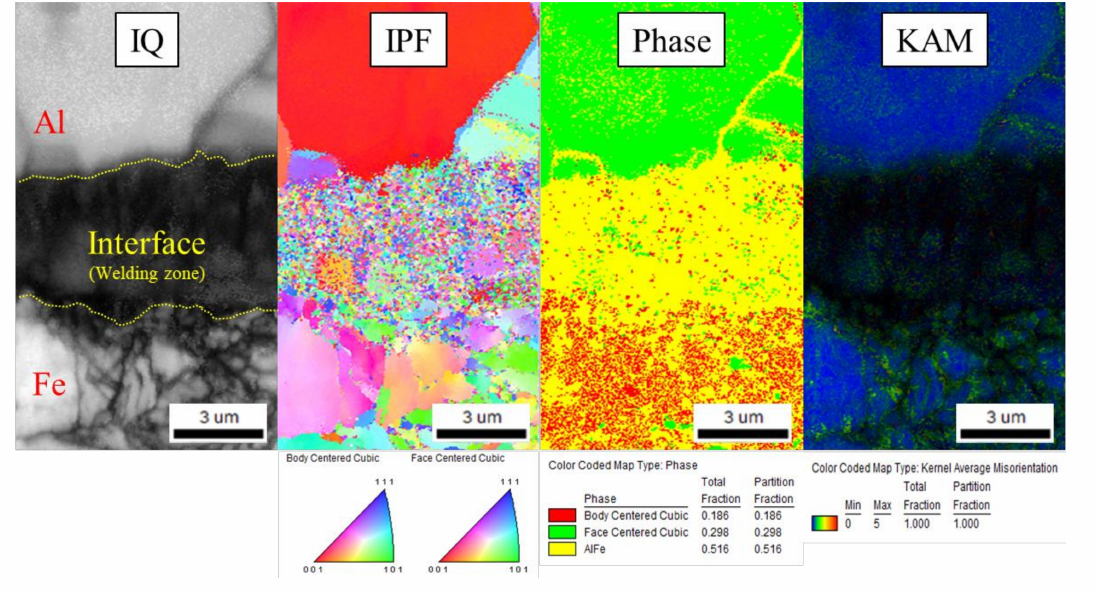
Figure 18. EBSD investigation in the welded VFAW